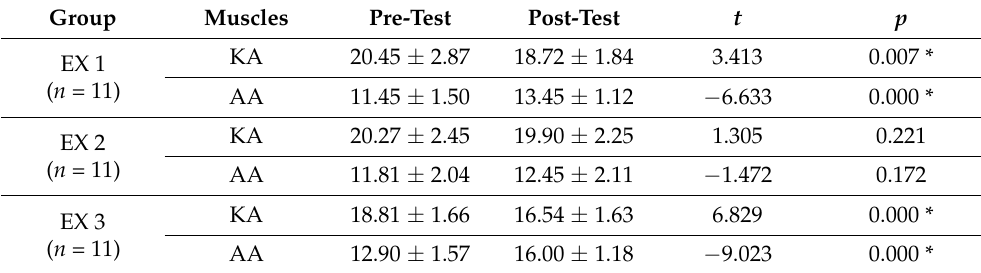
Table 4. Comparison of gait ability during heel-off between groups. Group